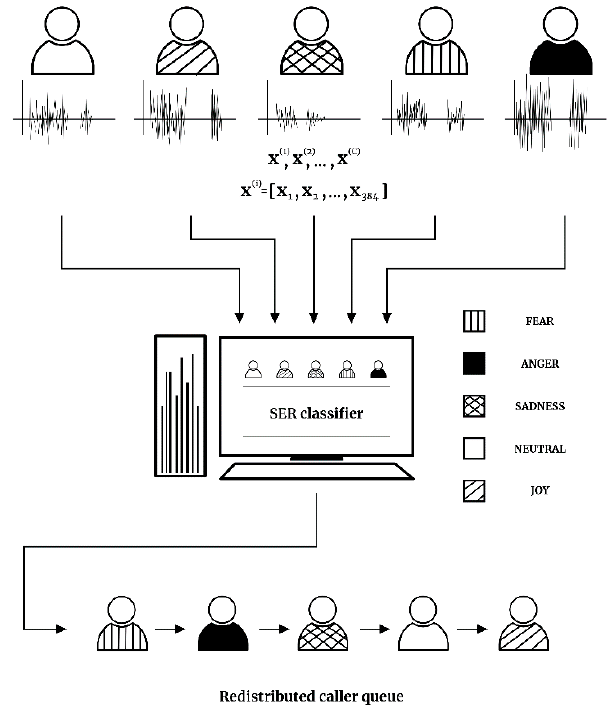
Figure 2. Proposed call redistribution based on SER